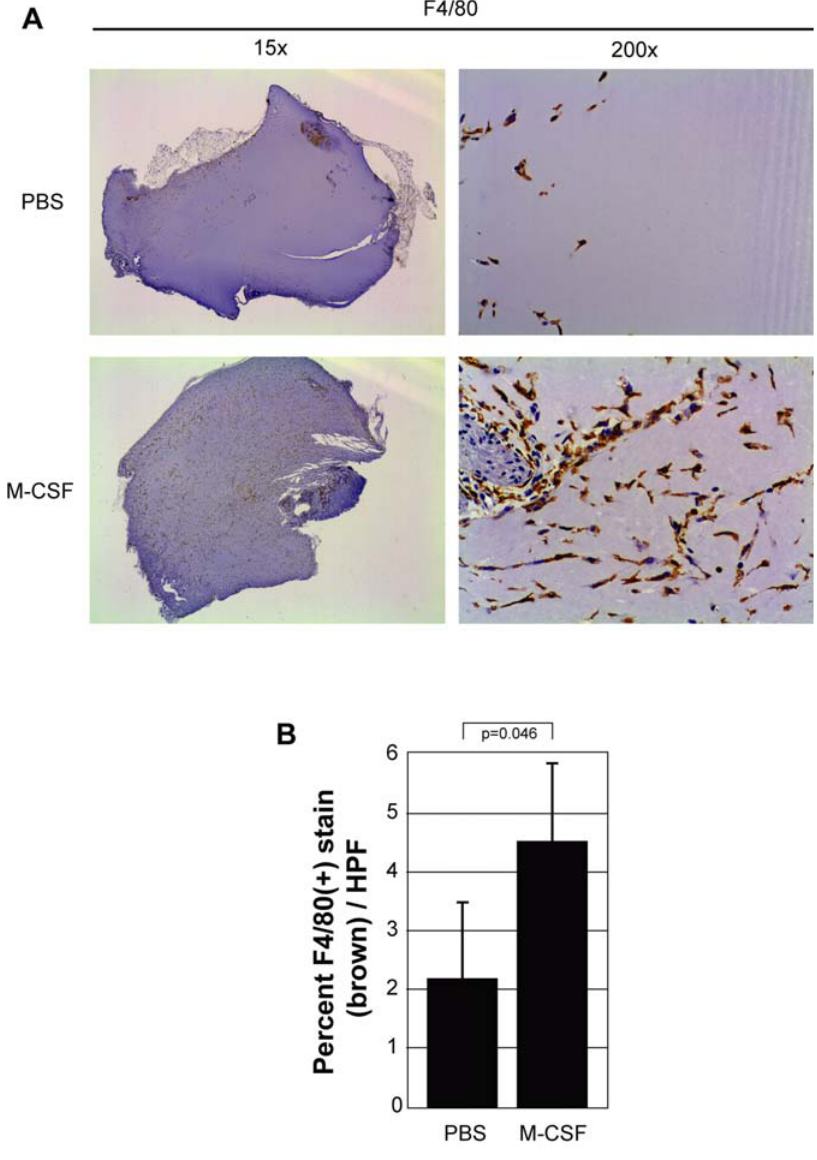
Figure 6. M-CSF induces mononuclear phagocyte recruitment invivo . A) Matrigel TM was resuspended with PBS (PBS) or rmM-CSF (100 ng/ ml) (M-CSF) at 4 u C overnight and then injected subcutaneously into mice. Matrigel TM was left in situ for 10 days and then harvested. The plugs were stained for mononuclear phagocytes using an anti-mouse F4/80 antibody. Brown staining represents F4/80( + ) cells within the plug. Pictures shown were taken using a dissecting microscope (1.5 6 objective lens) (left) to display overall mononuclear phagocyte influx between conditions as well as an inverted microscope (20 6 objective lens) (right) to show detailed staining of these cells. B) The percent of F4/80( + ) cells (brown stain) per plug was evaluated from 15 digital images captured randomly in a blinded manner. Adobe Photoshop histogram pixel analysis of the brown stain was used for quantification. This data represents three plugs per group.